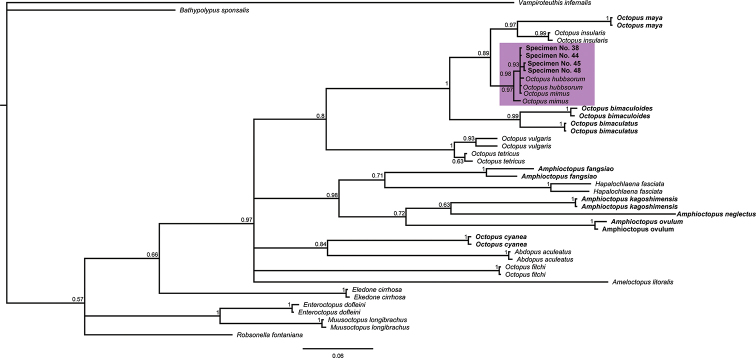
COI Molecular phylogeny. Molecular phylogeny of COI-gene sequences (474 bp: 193 variable and 281 conserved) of ocellate and non- ocellate octopus species. Ocellated octopuses are bold-faced. Purple rectangle indicates the clade containing the specimens evaluated in this study.